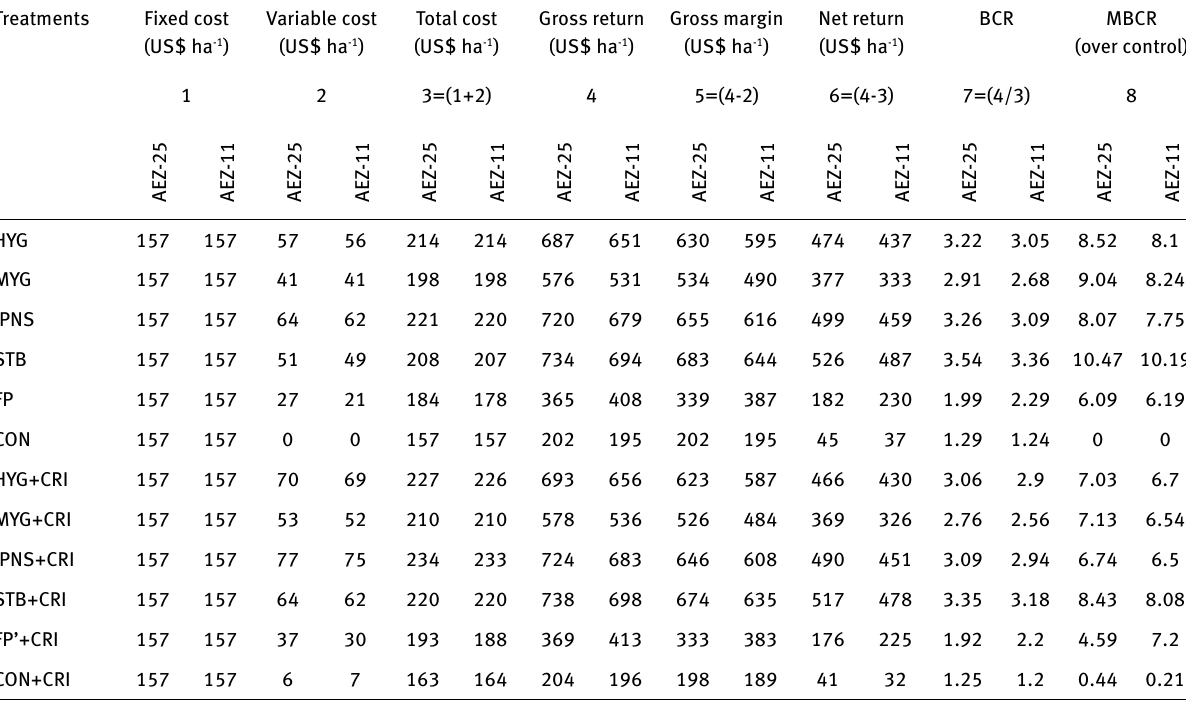
Table 7: Economics of different nutrient management strategies in rainfed monsoon rice in two locations (AEZ-25 & AEZ-11) of Bangladesh (mean of 2011 and 2012)